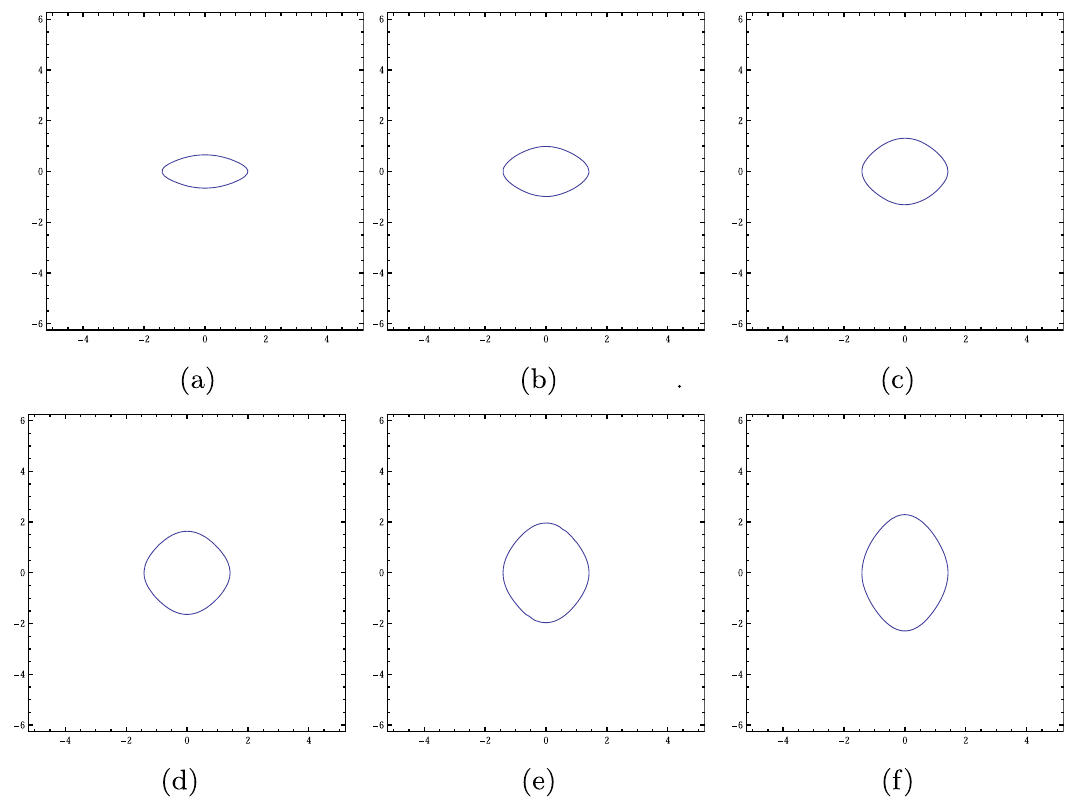
Figure 4: The shape of metric ball ( ) δ x x , t 1 2 when we fi x = t 0.5 , = a 1 and b changes from 1 to 3.5 in the interval of 0.5.